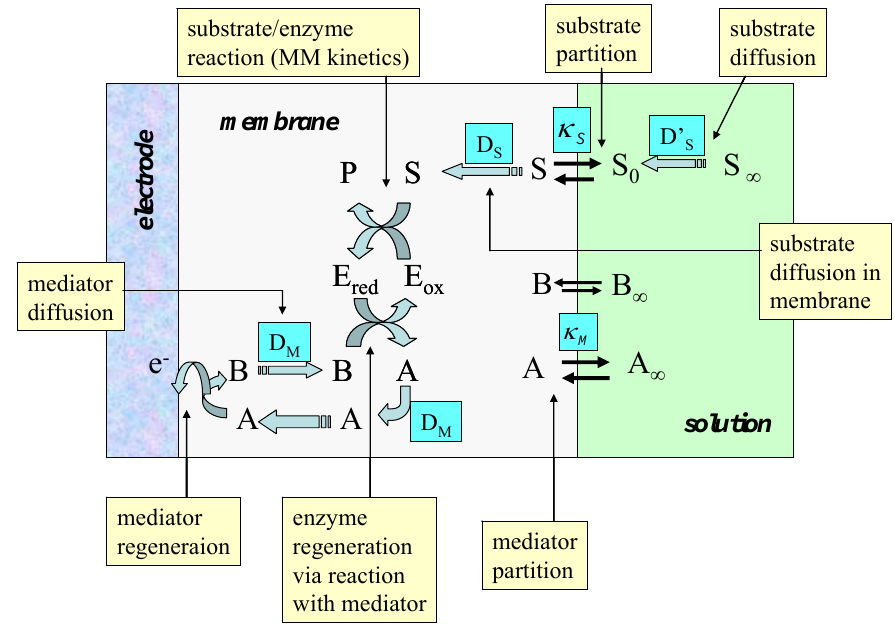
Figure 11. Schematic of a typical enzyme membrane electrode illustrating the various transport and kinetic processes which may serve as rate determining